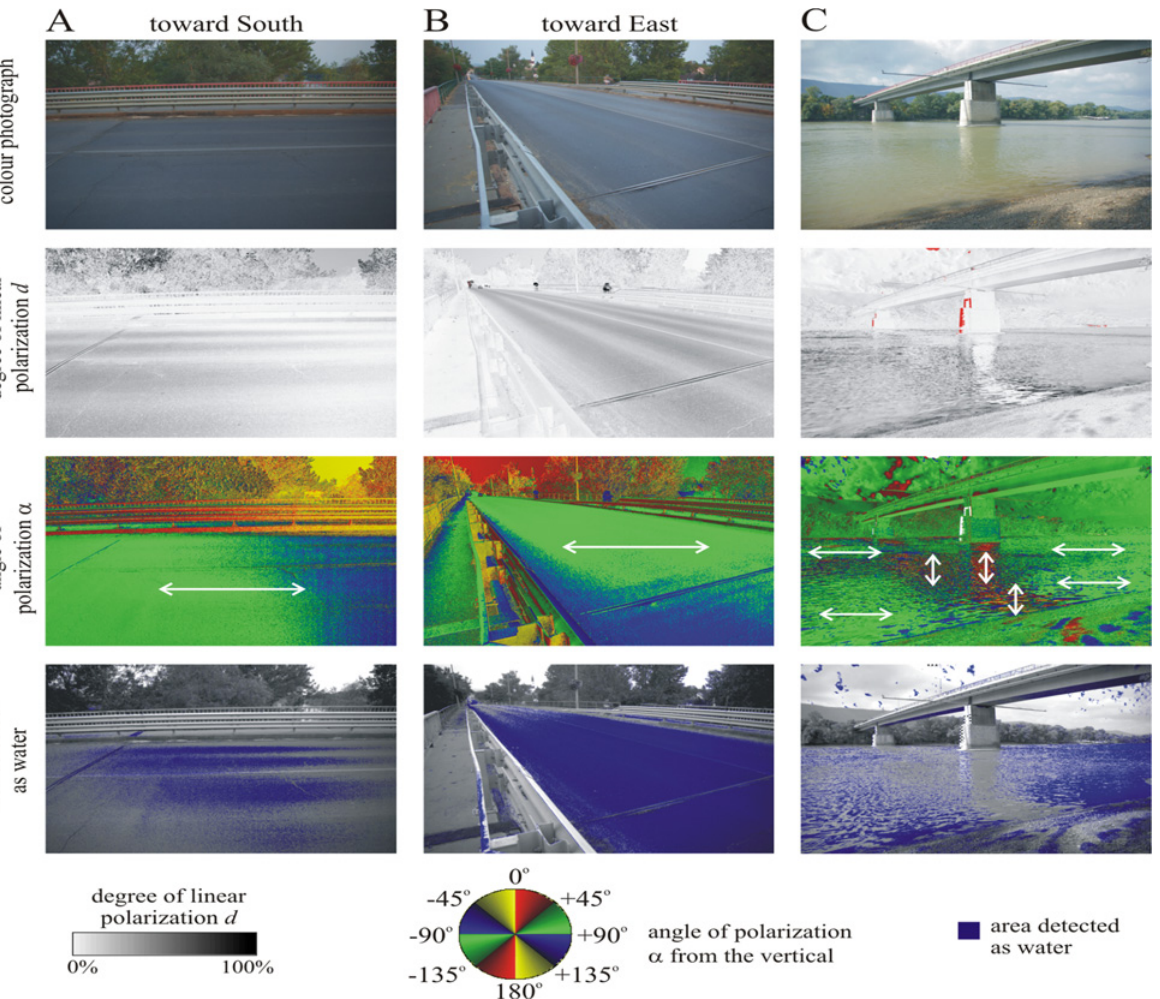
Fig 5. As Fig. 3 for the same asphalt road illuminated by light from the clear sky after sunset and measured from two different directions of view, when the optical axis of the polarimeter pointed toward South (A) and East (B). (C) As A and B for the down-stream side of the bridge and the Danube